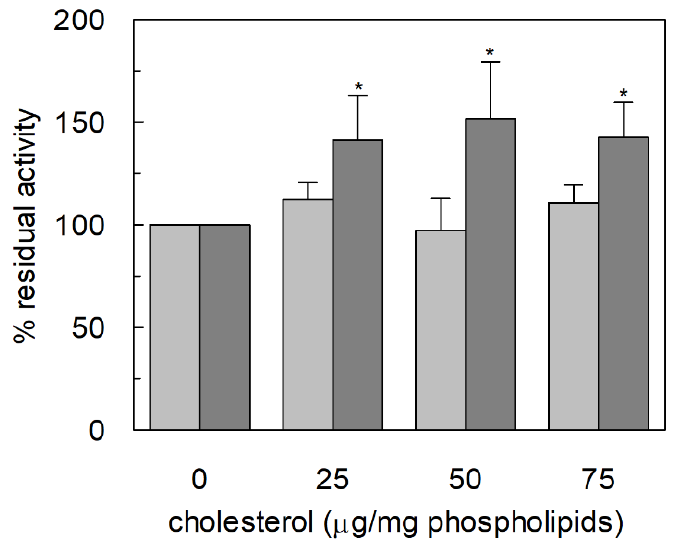
uptake on pH was evaluated with an optimum reached between pH 6.5 and 7.5, as in the case of the antiport reaction [15] (Figure 4).